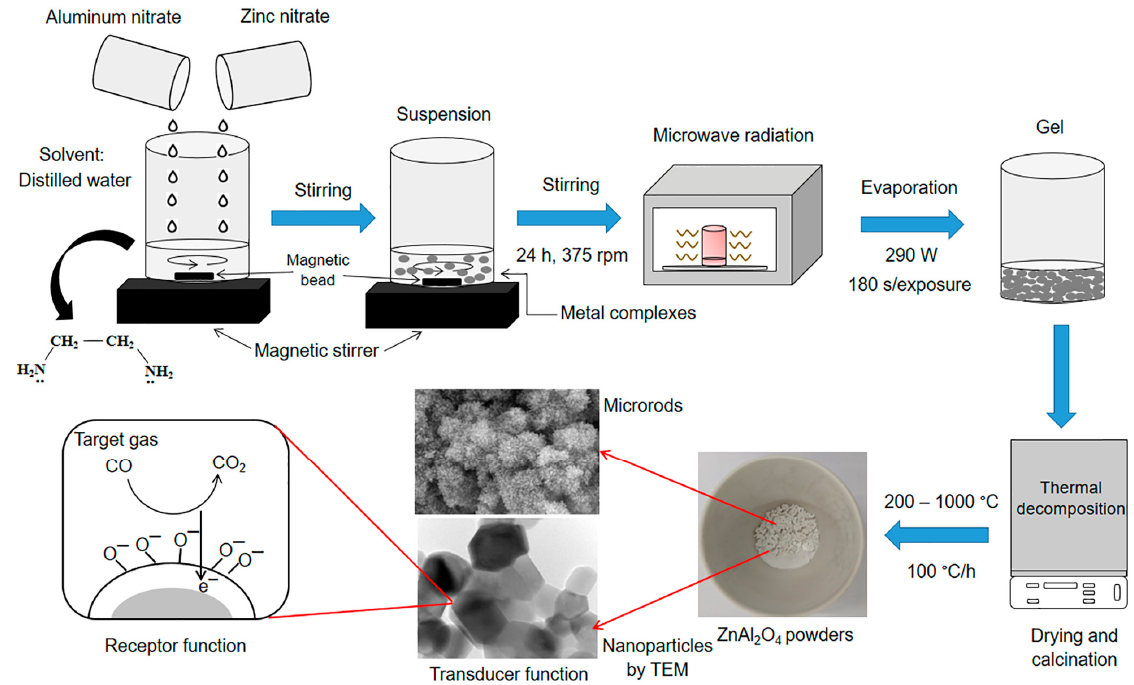
Figure 1. Schematic of the nanostructured ZnAl 2 O 4 ′ s synthesis through the aqueous sol-gel route for gas sensing applications.